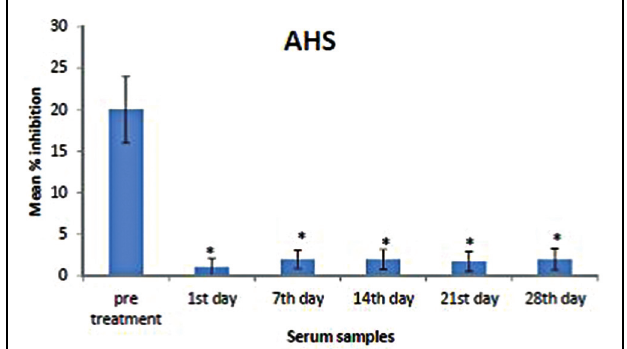
FIGURE 3 | Mean percentage of inhibition of AHS in the pre-treatment and post-treatment serum samples. Analysis was performed by competitive ELISA. AHS concentrations in the pre-treatment sera were significantly higher than those in the post-treatment samples (days 1, 7, 14, 21, and 28). The amount of AHS present was proportional to the percentage inhibition of substrate hydrolysis. Asterisk denotes statistical significance ( p < 0.05) of post-treatment samples compared to that of pre-treatment sample ( n =